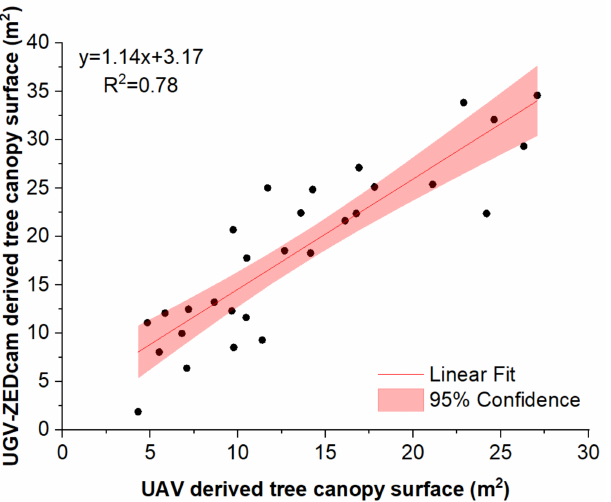
Figure 5. Comparison between the canopy size estimated by the ground-based and the aerial-based systems used in the study; the colored area shows the lower and upper confidence (95%)